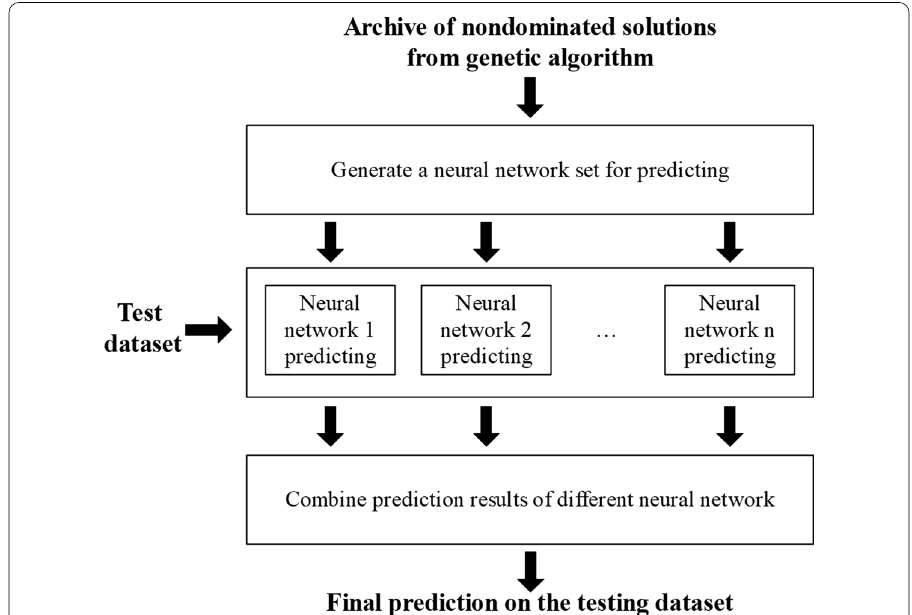
Fig. 3 Test session of the proposed